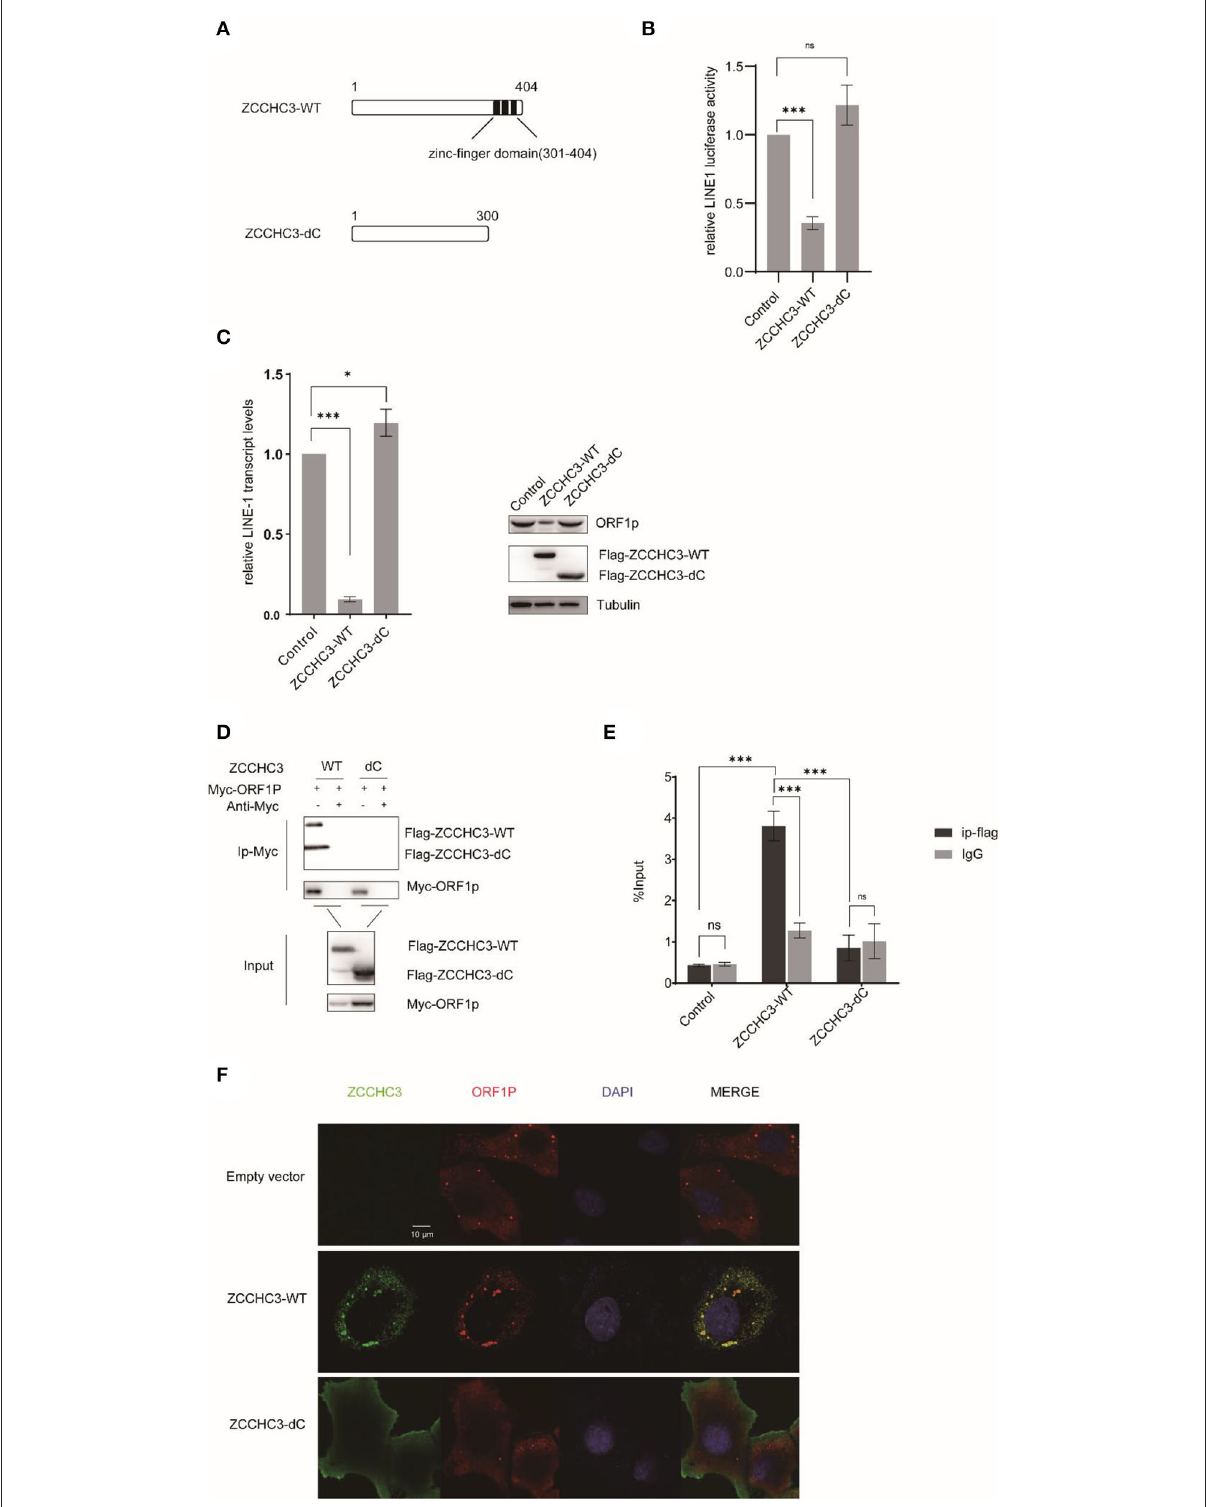
FIGURE5 The zinc-finger domain is essential for ZCCHC3-mediated LINE-1 restriction. (A) The illustration of ZCCHC3 truncation. (B) ZCCHC3 dc does not inhibit LINE-1. HEK293T cells were transfected with pWA367 and either empty vector, Flag-ZCCHC3 or Flag-ZCCHC3-dc. 4